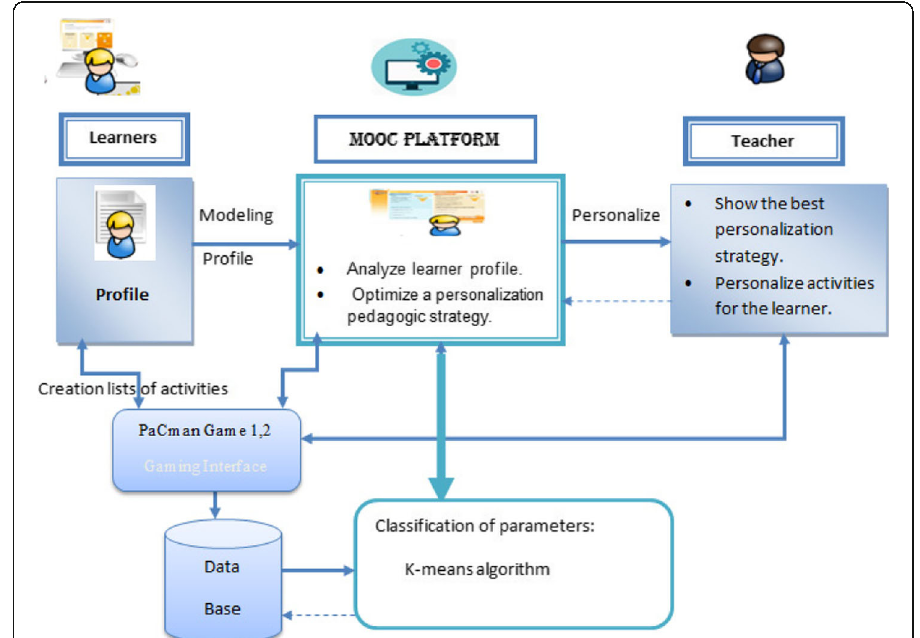
Fig. 1 Proposed architecture of the MOOCs personalization